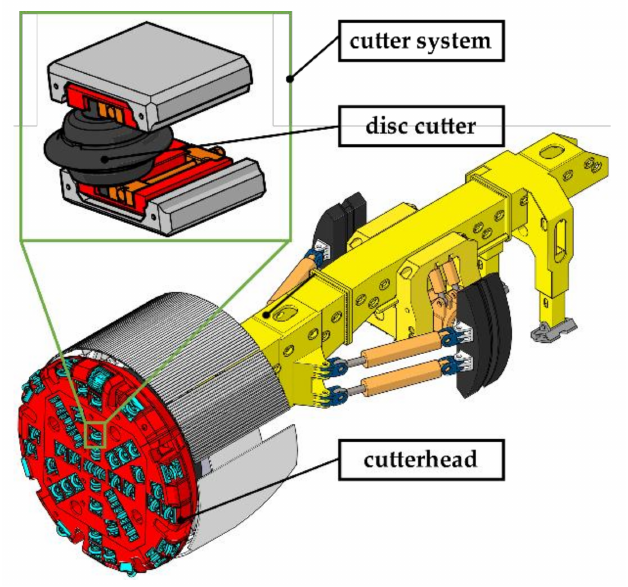
Figure 1. Layout of the disc cutter in a tunnel boring machine